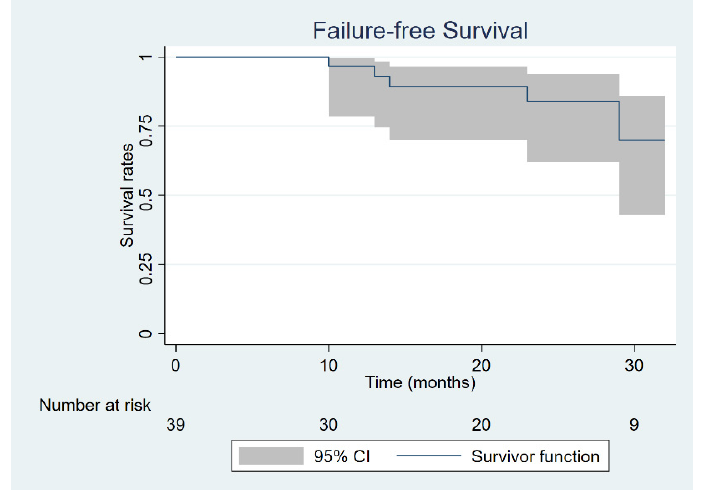
Figure 4. Failure-free survival.